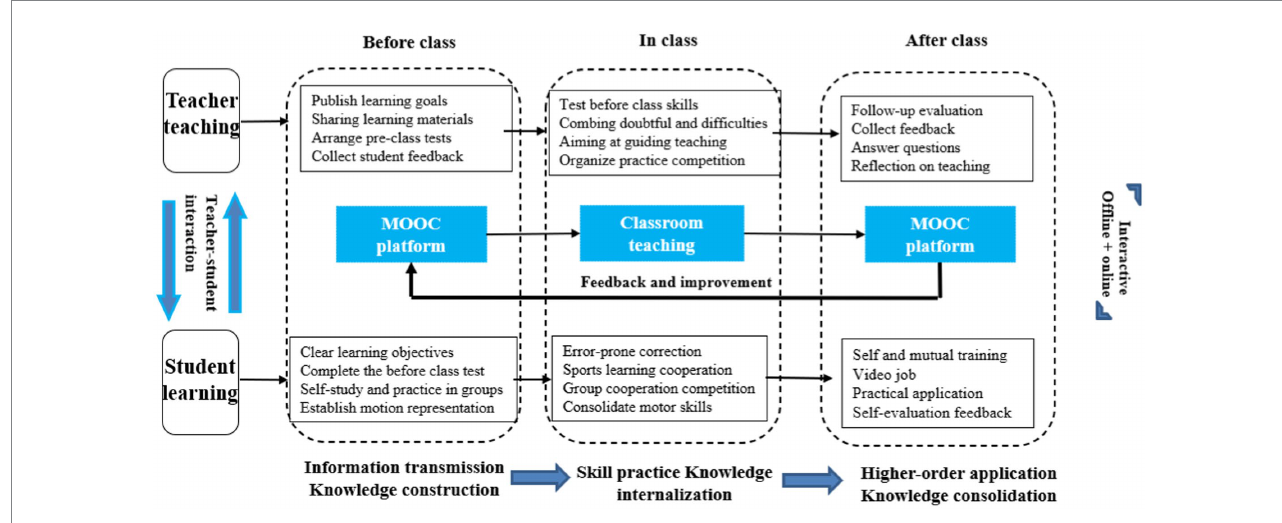
FIGURE 1 Teaching design of “MOOC+ flipped classroom” for basketball courses in colleges and